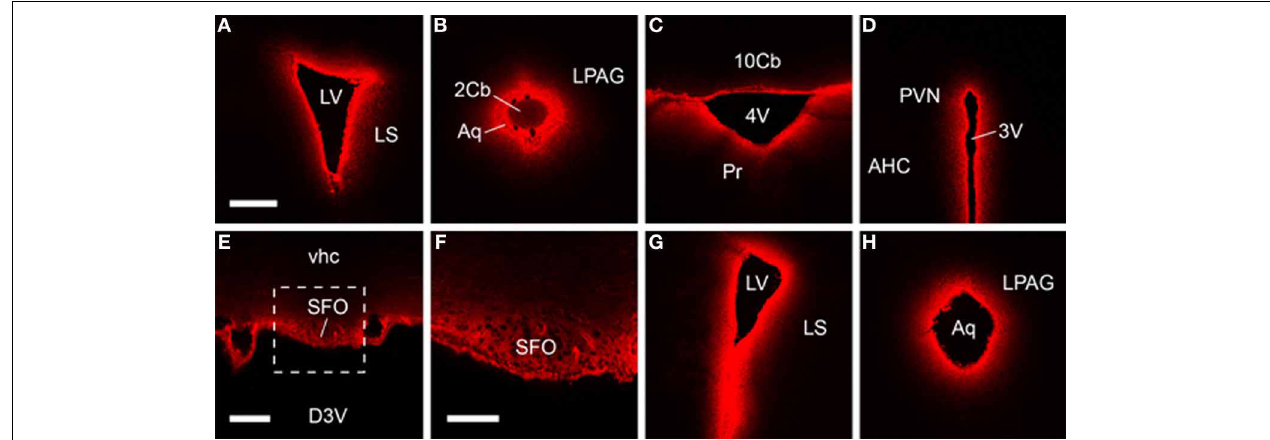
FIGURE 4 | Fluorescent confocal micrographs of coronal sections from brains harvested 30min after icv infusion, which demonstrate Cy5.5-H2 relaxin (A–F), Cy5.5-H2:A(4-24)(F23A) (G) and Cy5.5-INSL3 (H) highly concentrated within brain tissue proximal to the cerebral ventricle wall. Rostral-dorsal location, relative to bregma (mm): (A) 0.38; (B) − 4.96; (C) − 6.24; (D) − 0.82; (E,F) − 0.46; (G) 0.86; (H) − 4.84. Scale bars, (A–D,G,H) 300 μ m; (E) 100 μ m; (F)